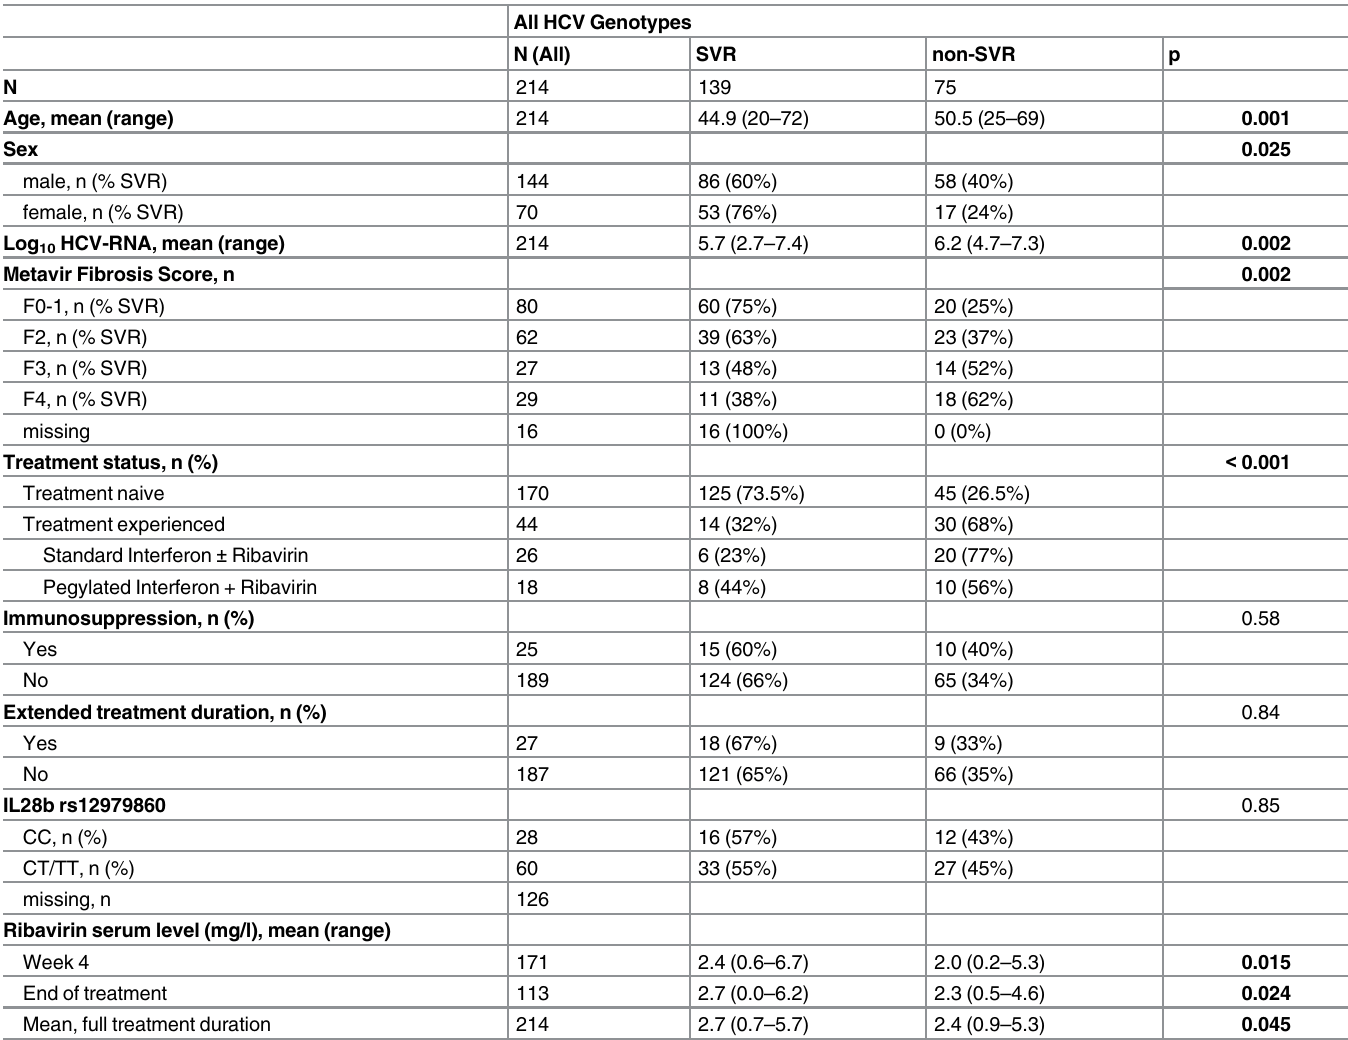
Table 1. Patient characteristics and SVR